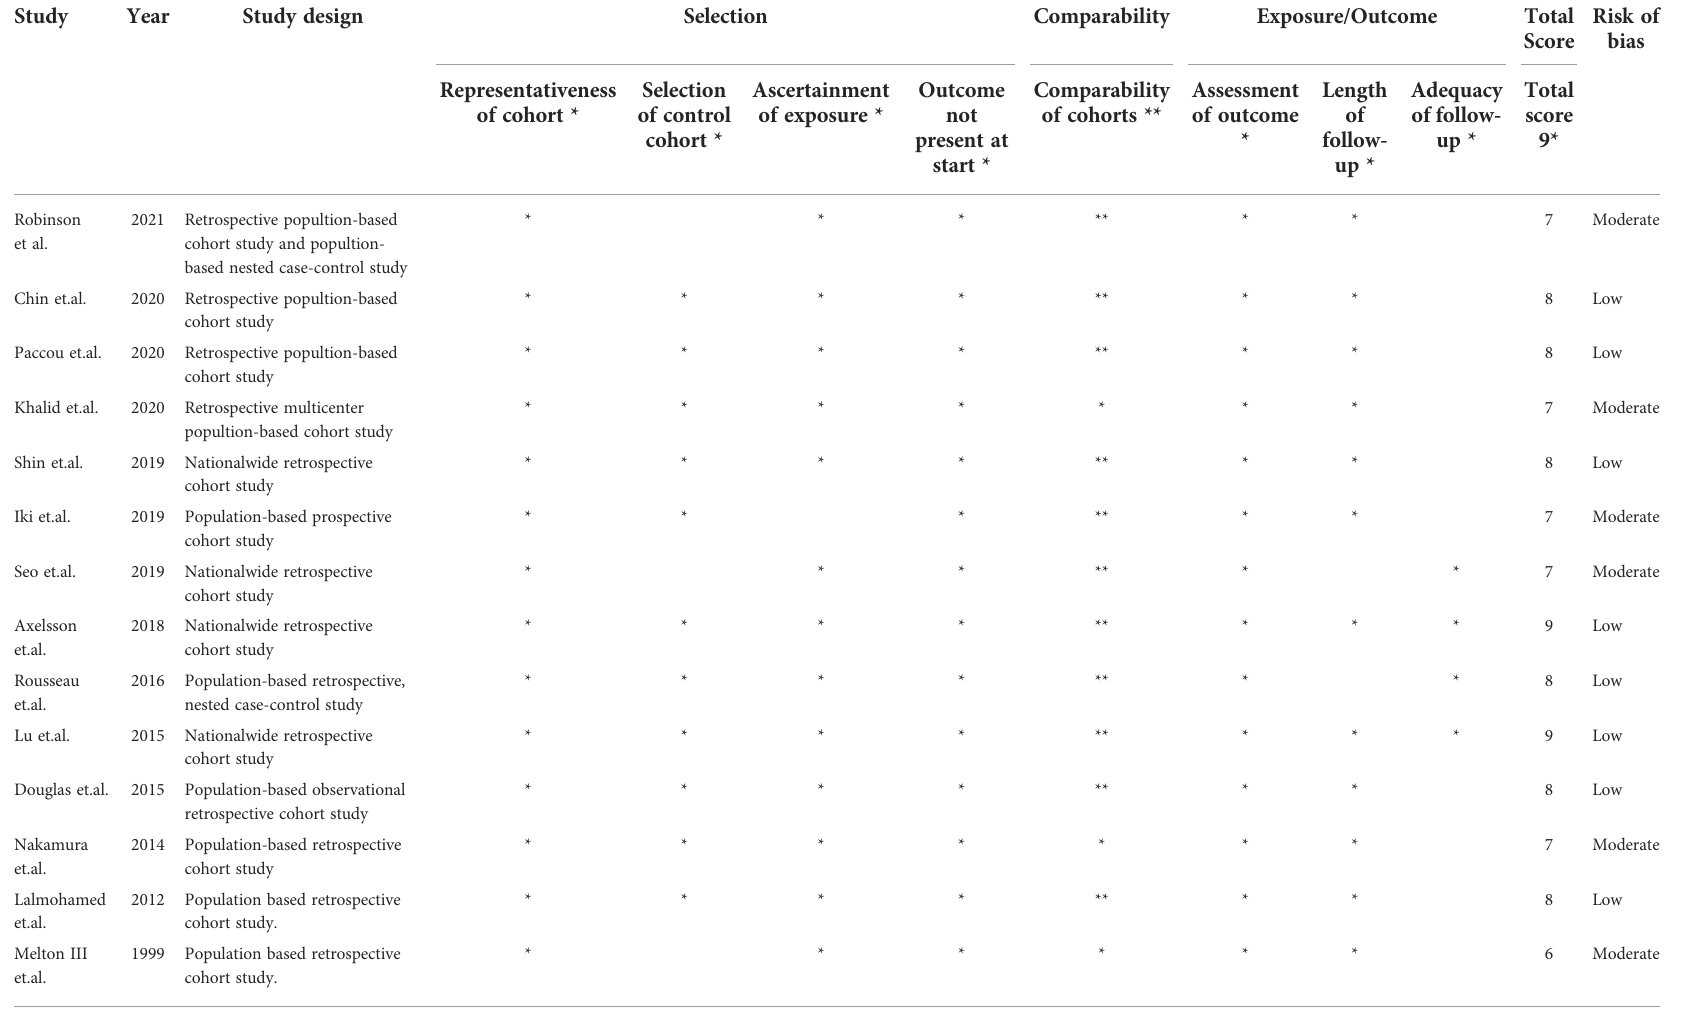
TABLE 2 Methodological quality score of the included studies based on the Newcastle – Ottawa scale (NOS) tool. Study